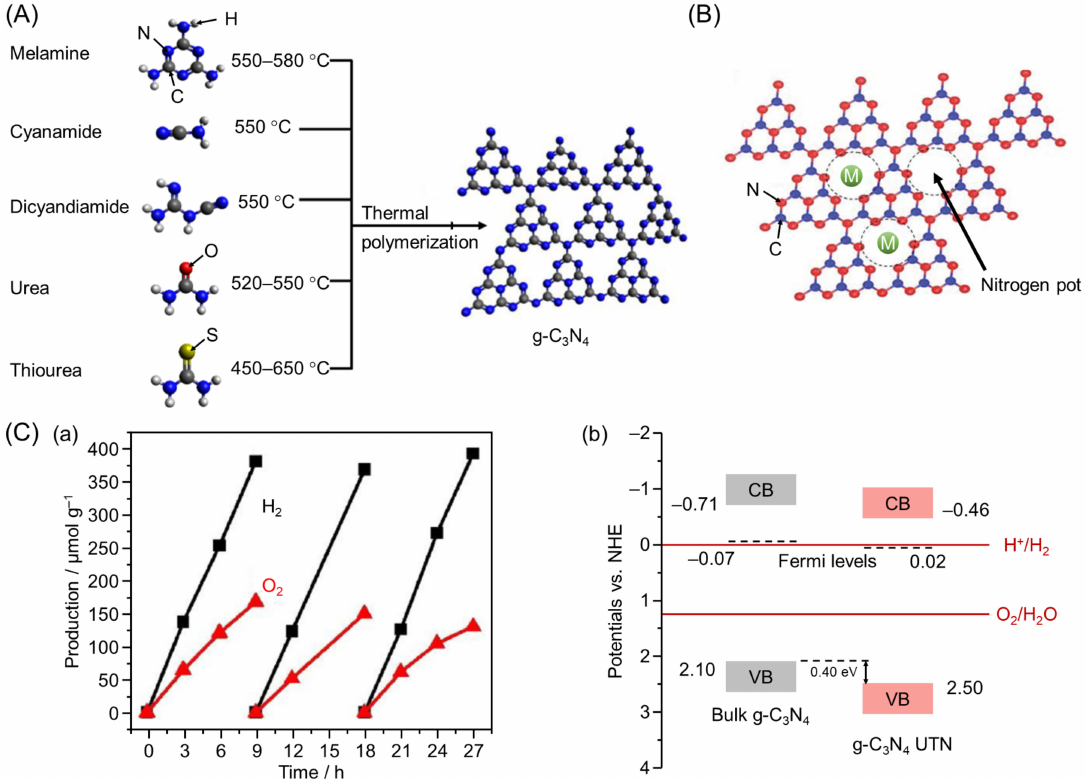
Figure 13. ( A ) Schematic illustration of the synthesis process of g-C 3 N 4 by thermal polymerization of different precursors, such as melamine, cyanamide, dicyanamide, urea, and thiourea. Black, blue, white, red, and yellow balls denote C, N, H, O, and S atoms, respectively. ( B ) Schematic diagram of a perfect g-C 3 N 4 sheet constructed from tri- s -triazine units. Red and blue balls denote N and C atoms, respectively. indicates the nitrogen pot filled with six nitrogen lone-pair electrons, which (cid:35) are potentially ideal sites for metal (M) inclusion. ( C ) ( a ) The photocatalytic overall water splitting of g-C 3 N 4 ultra-thin nanosheets with ∼ 1.4 wt% of Pt atoms as cocatalyst from pure water under Vis-light irradiation ( λ > 400 nm). ( b ) The band edge positions of bulk g-C 3 N 4 and g-C 3 N 4 ultra-thin nanosheets. Reproduced with permission from references [152,156,171]. Copyright 2016 American Chemical Society, 2014 The Royal Society of Chemistry, and 2021